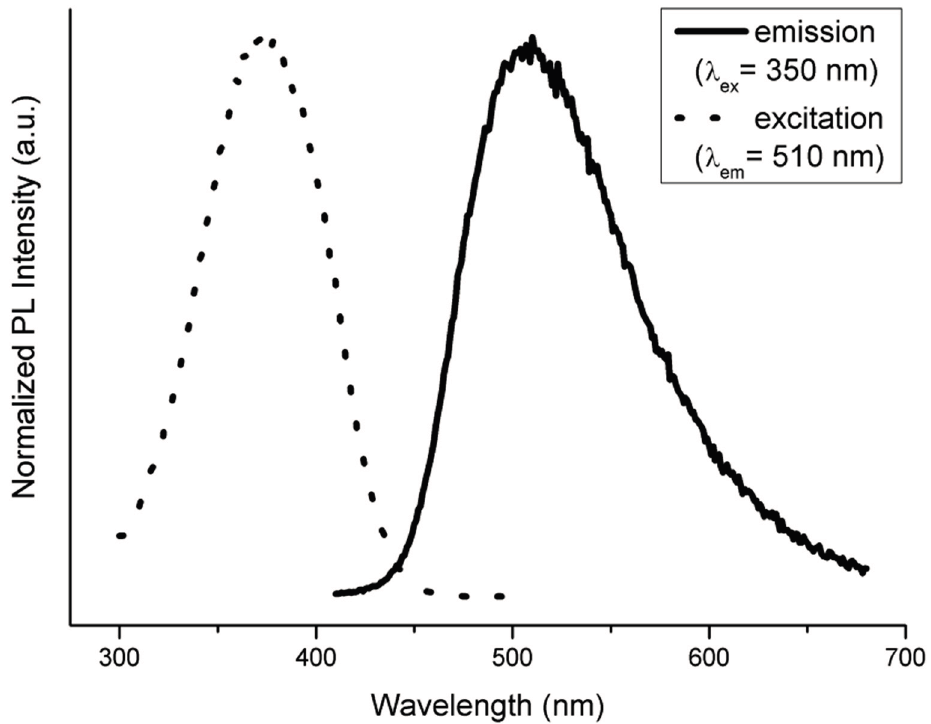
Figure 8. The excitation and emission spectra of water solution of potassium salt of N -salicylideneglycinate. The dotted line represents the excitation spectrum and the solid line represents the region of emission maxima at 510